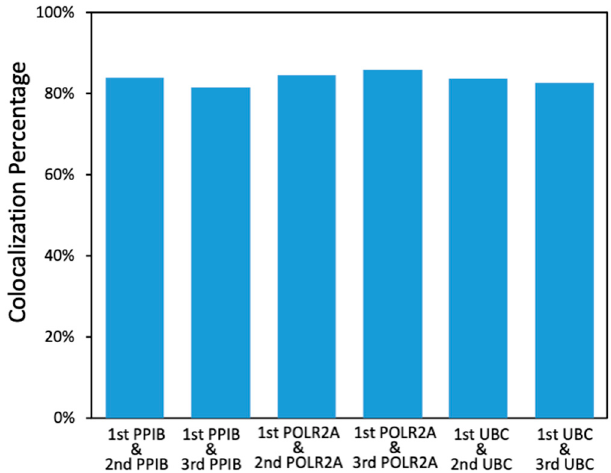
Figure 4. Percentage of the PPIB, POLR2A, and UBC spots identified in the first cycle that reap- peared in the following